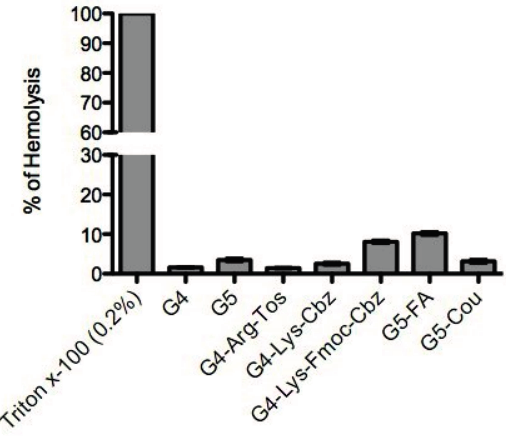
Figure 3. Percentage of hemolysis of red blood cells subjected to a concentration of 4 µM of the different dendrimers